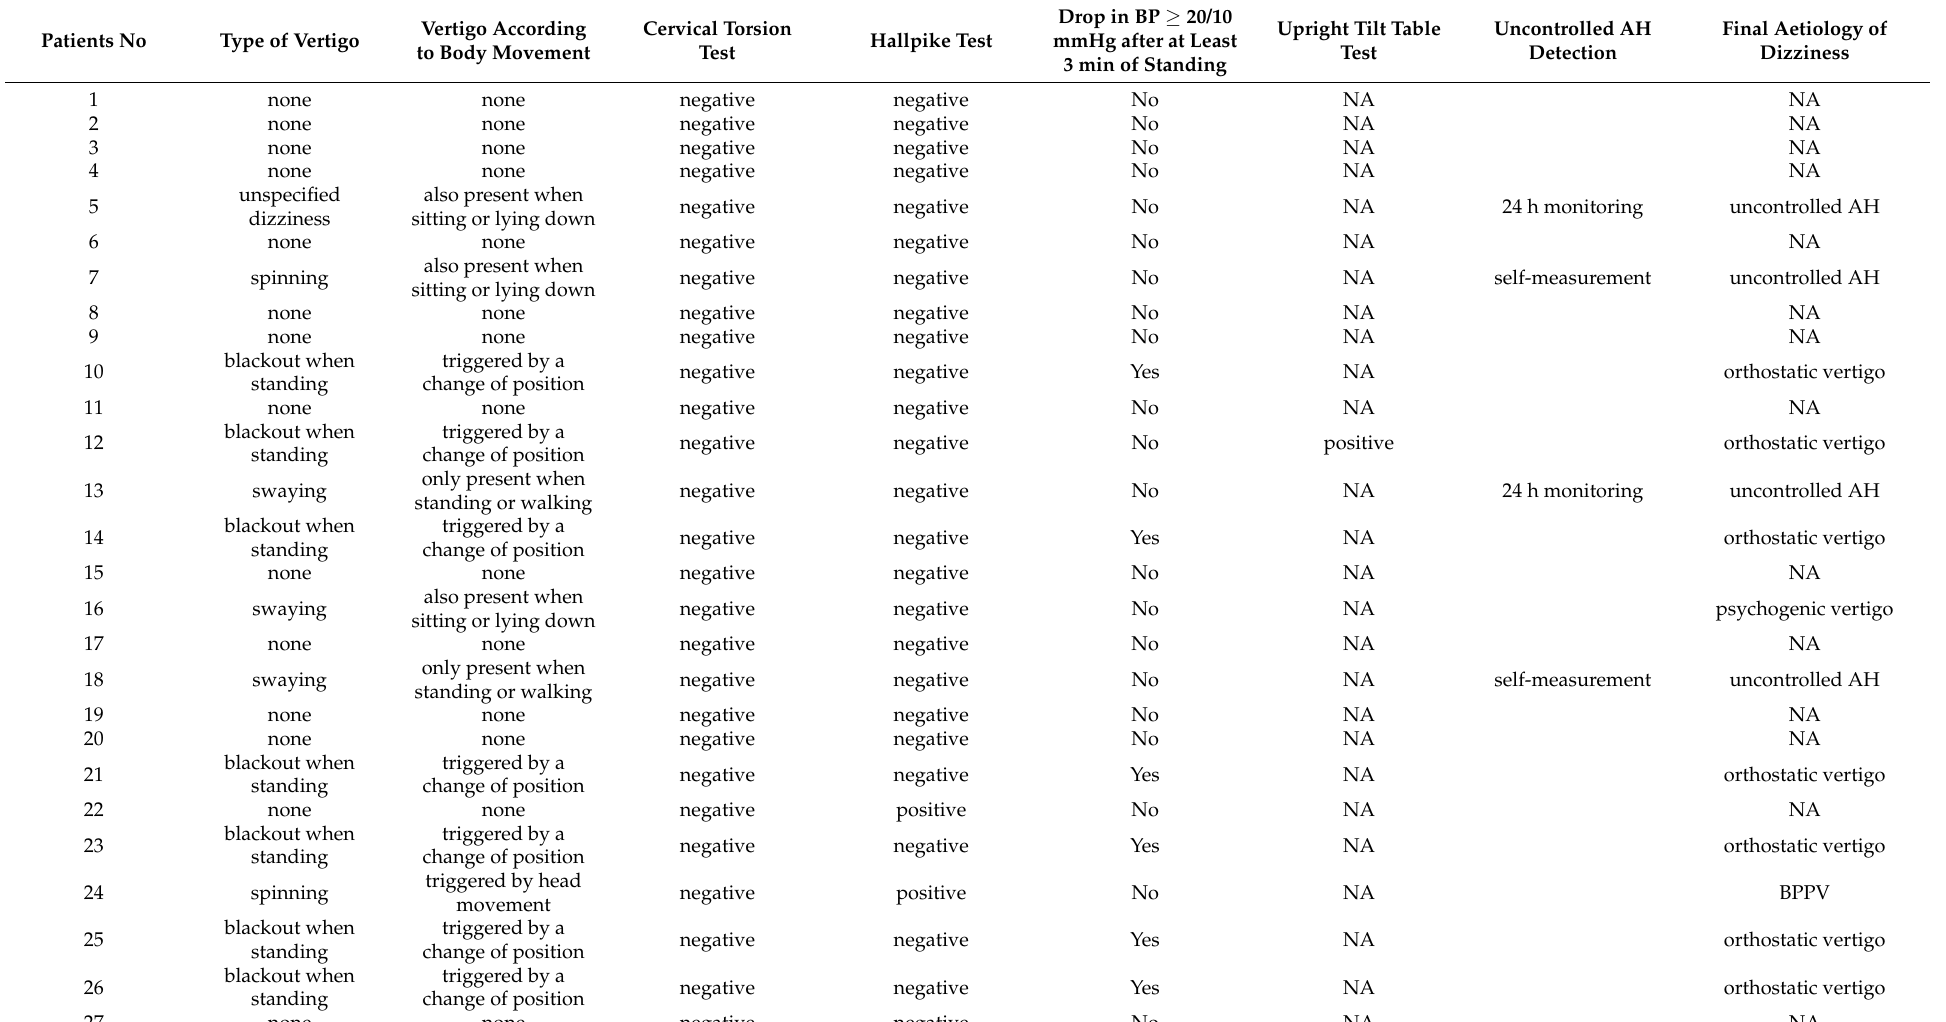
Table 2. Detailed characteristics of dizziness/vertigo and its aetiology in DCM